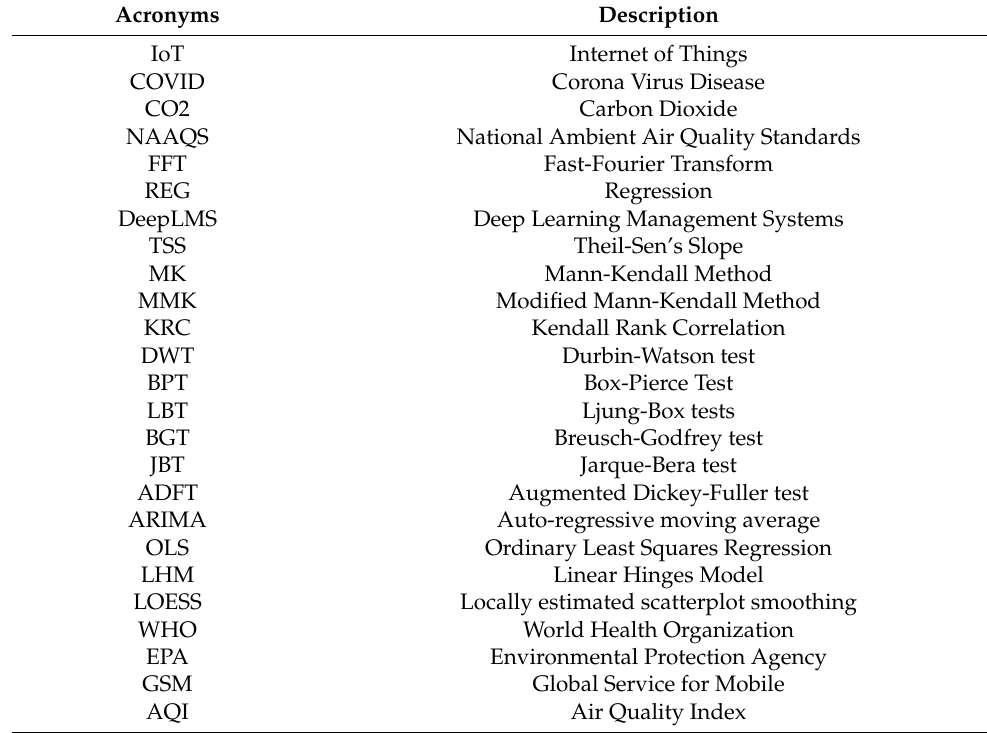
Table 2. List of